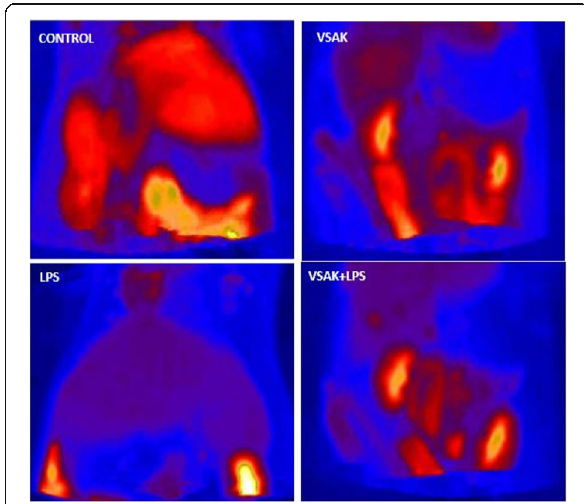
Fig. 1 (abstract P38). PET representative images of the abdominal cavity of each of the four experimental animal groups